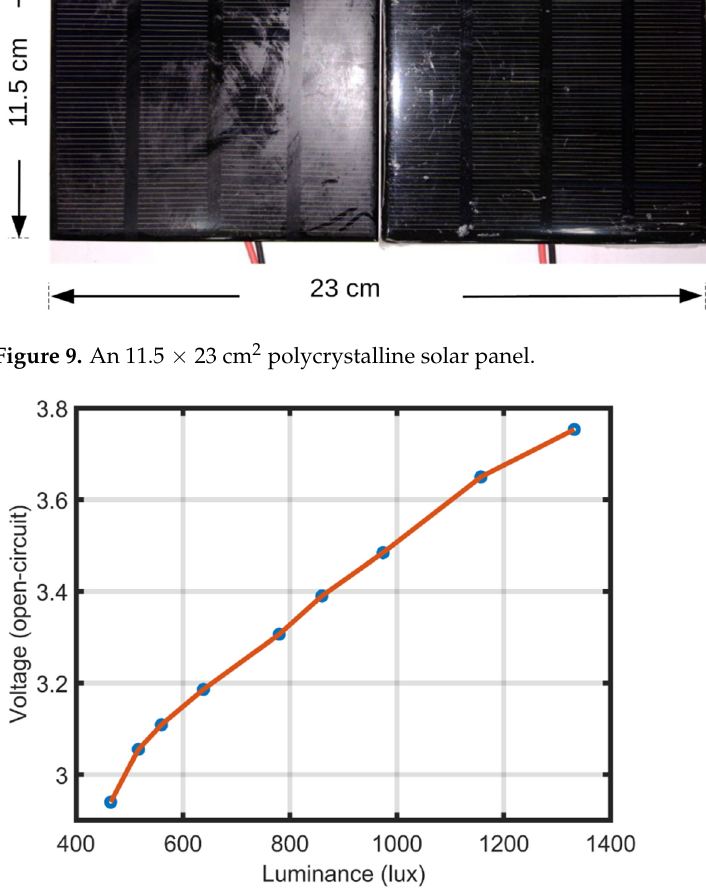
Figure 10. The measured relation between the luminance and the generated open-circuit